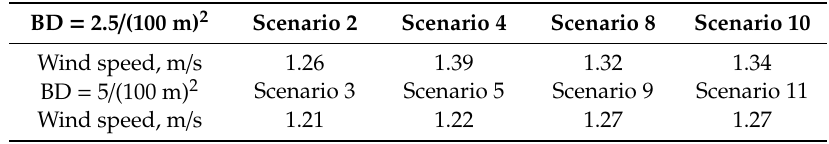
Table 6. Comparison of 24-h-averaged mean wind speed between pairs of scenarios with di ff erent BD values.